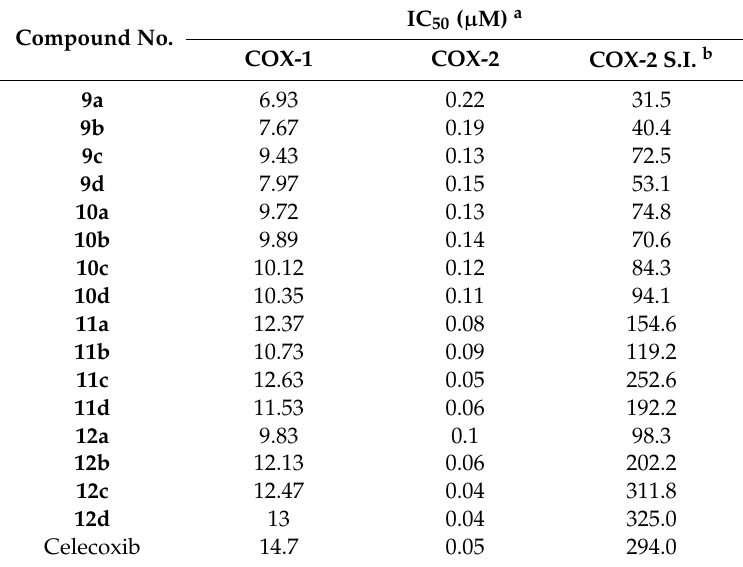
Table 1. In vitro COX-1 and COX-2 inhibition of mercapto-1,2,4-triazole Schi ff bases derivatives ( 9a–d , 11a–d , 12a–d ) and Celecoxib. Compound